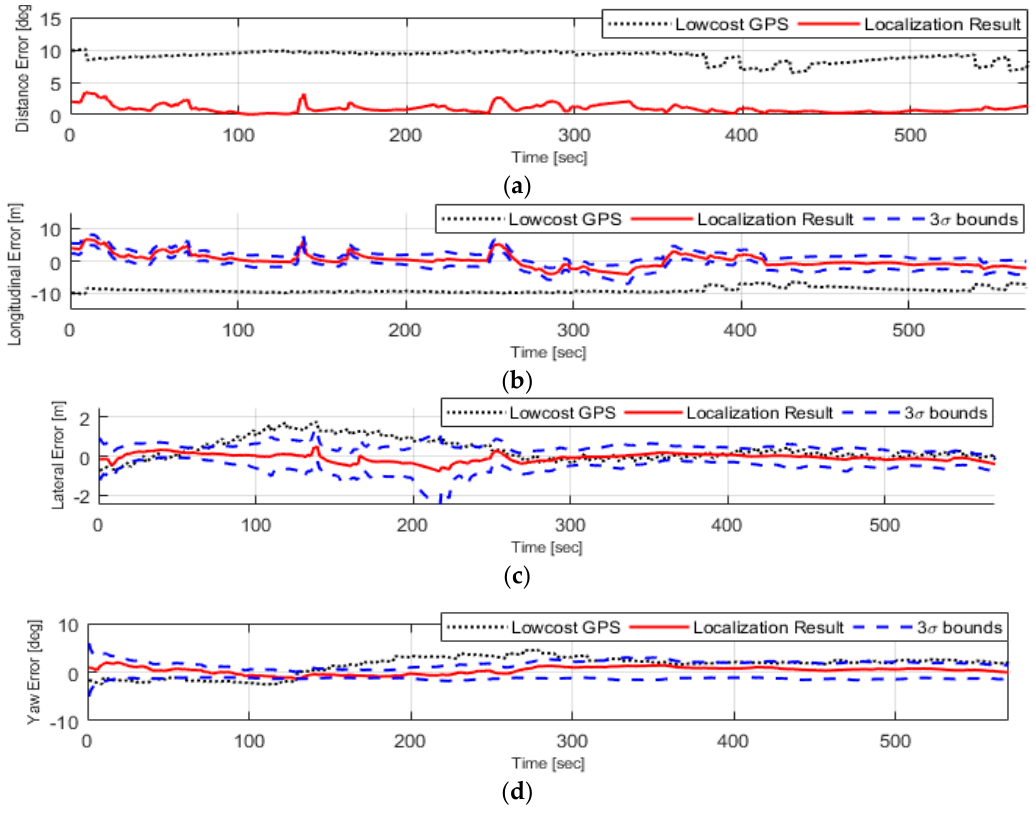
Figure 7. Test data-based localization simulation results on highways. ( a ) Distance error; ( b ) Figure7. Testdata-basedlocalizationsimulationresultsonhighways. ( a )Distanceerror; ( b )longitudinal longitudinal position error; ( c ) lateral position error; ( d ) yaw angle error. position error; ( c ) lateral position error; ( d ) yaw angle